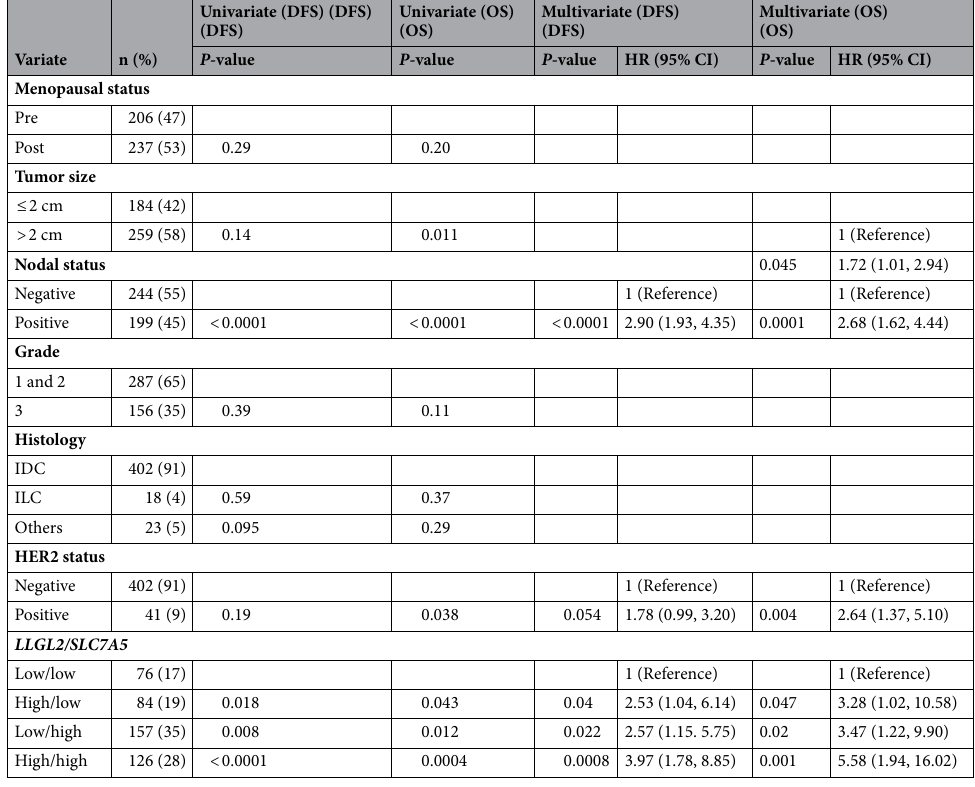
Table 2. Univariate and multivariate analyses of factors associated with DFS and OS including LLGL2/SLC7A5 in ERα-positive patients. IDC invasive ductal carcinoma, ILC invasive lobular carcinoma, HER2 human epidermal growth factor receptor